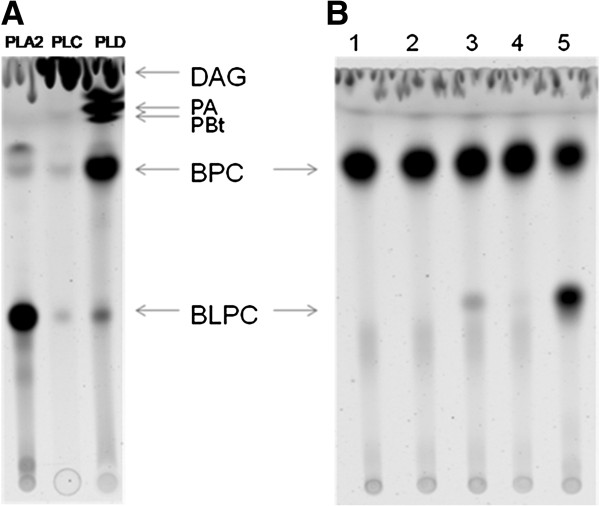
Thin-layer chromatography (TLC) demonstrates phospholipase A2 activity of Plp. BODIPY-labeled phosphatidylcholine (BPC) was incubated with various standard enzymes or sample preparations for 1 h at 37°C. Subsequently, the lipids were extracted and separated by TLC. (A) The cleavage patterns of BPC by standard proteins PLA2, PLC, and PLD were able to distinguish the different phospholipase activities. (B) Cleavage patterns of BPC by supernatants (lanes 2 and 3) and cell lysates (lanes 4 and 5) from E. coli DH5α containing cloned plp (lanes 3 and 5) or just the cloning vector pSUP202 (lanes 2 and 4). Lane 1 contains only BPC incubated in the presence of PBS buffer. BLPC, BODIPY-labeled lysophosphatidylcholine; PA, phosphatic alcohol; PBt, phosphaticbutanol; DAG, di-acylglycerol.